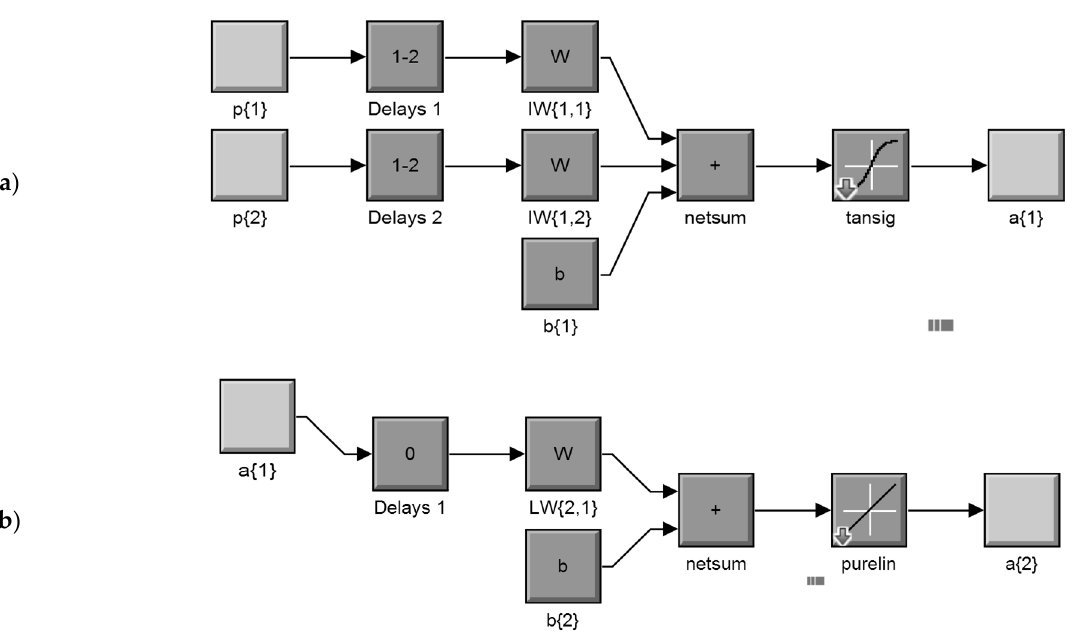
Figure 2. Abbreviated dynamic model structure, in a parallel mode, of the overall NARX network for the input layer ( a ) and the output layer ( b ), according to the Mat Lab Simulink ANN system model construction process (details in text).